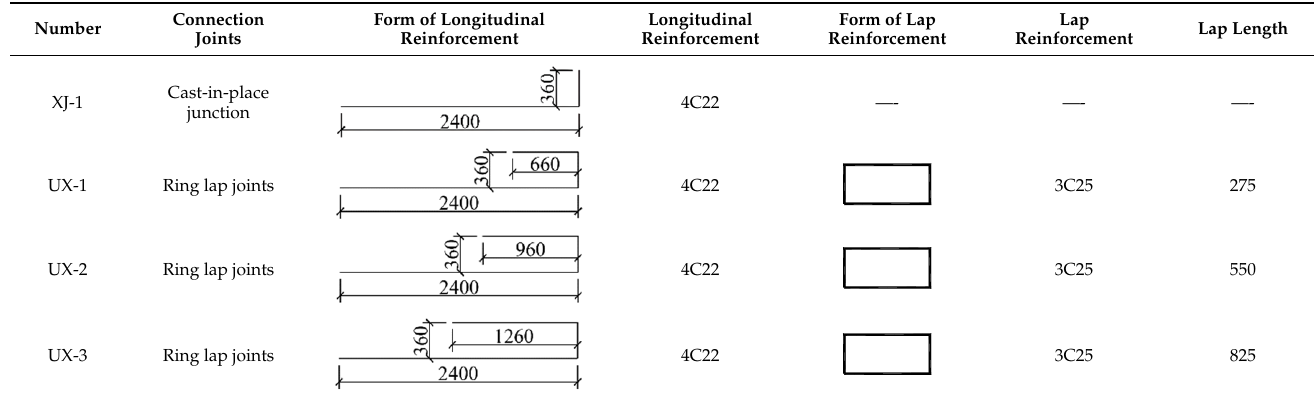
Table 2. Mechanical properties of concrete materials.